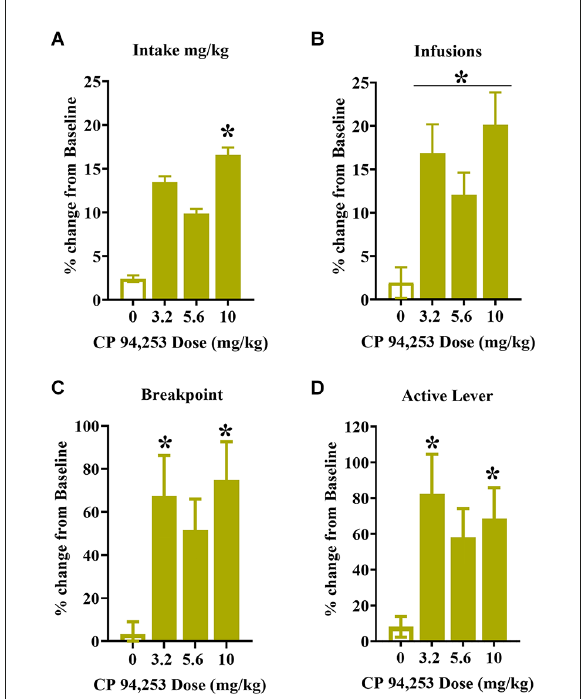
FIGURE5 Effects of CP94253 on the mean ± SEM mg/kg cocaine intake (A) , cocaine infusions (B) , breakpoints (C) , and active lever responses (D) during maintenance of daily cocaine self- administration (SA) under a progressive ratio (PR) schedule of reinforcement expressed as a % change from training baseline in male ( n = 9) and female ( n = 16) rats. There were no main effects or interactions with sex, therefore the data are collapsed across sex. *Difference from vehicle, Bonferroni t -tests, p < 0.0167.